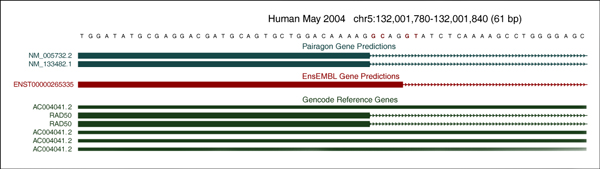
An annotated GC donor site that ENSEMBL misses. There is a GT dinucleotide four nucleotides downstream of the GC donor site (both dinucleotides are marked brown in the sequence). Pairagon identifies the correct donor site. (Screen shot obtained from UCSC Genome Browser web site [23].)